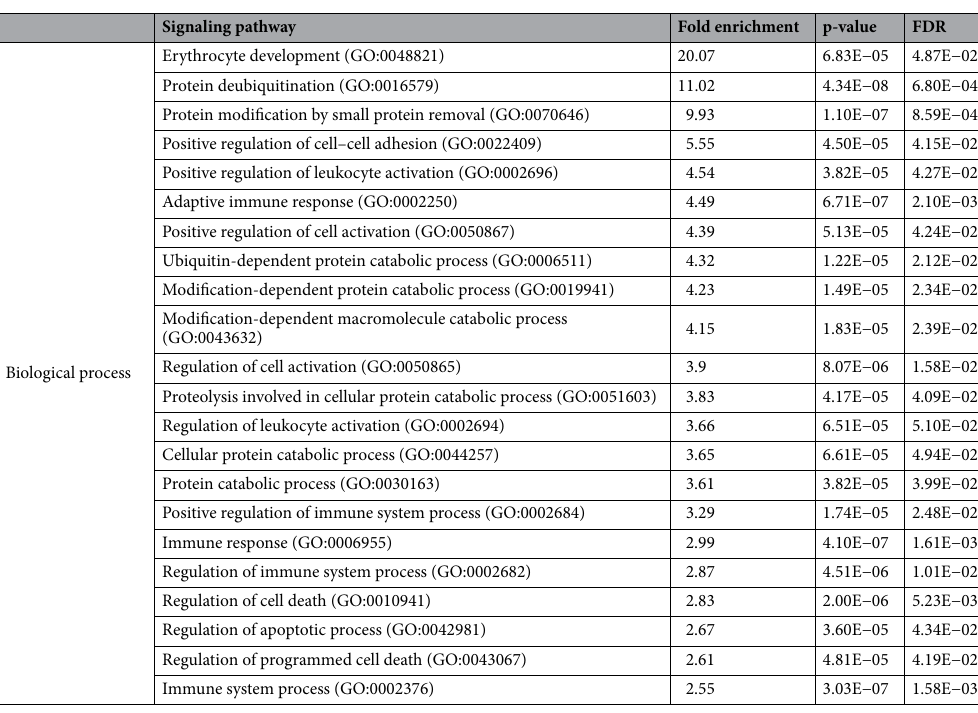
Table 3. Enrichment analysis for genes significantly up-regulated in CD16++ monocytes of loPE vs control groups performed in